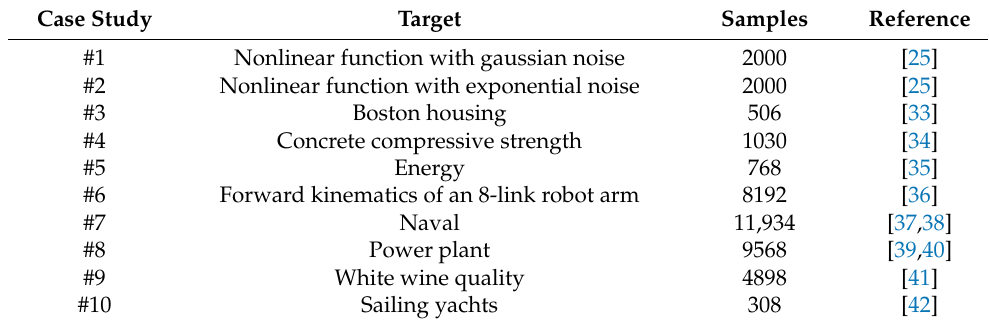
Table 1. Dataset used for